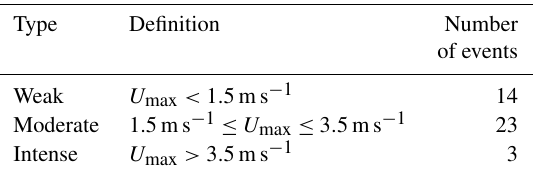
Figure 3. Box plots of the wind-speed profile at 3, 6 and 10m for the downslope events, (a) at the time of the onset and (b) at the time of the maximum value at 6m (from the onset to 00:00UTC) for each event. The red vertical line within blue boxes represents the median, the blue box delimits first and third quartiles, and whiskers delimit the most extreme points not considered outliers (red crosses). Black vertical lines and arrows pinpoint the limits for the wind speed at 6m that separate weak, moderate and intense downslope events. Table 3. Classification of the downslope events according to their maximum 10min averaged wind speed at 6m from the onset to 00:00UTC.